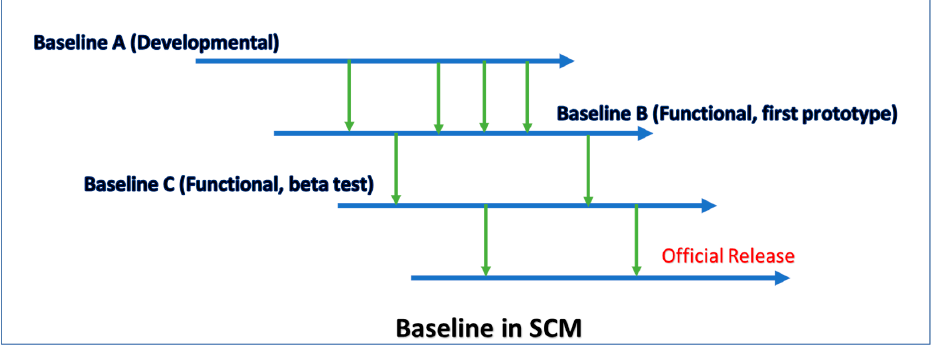
Figure 4. Baselines in SCM